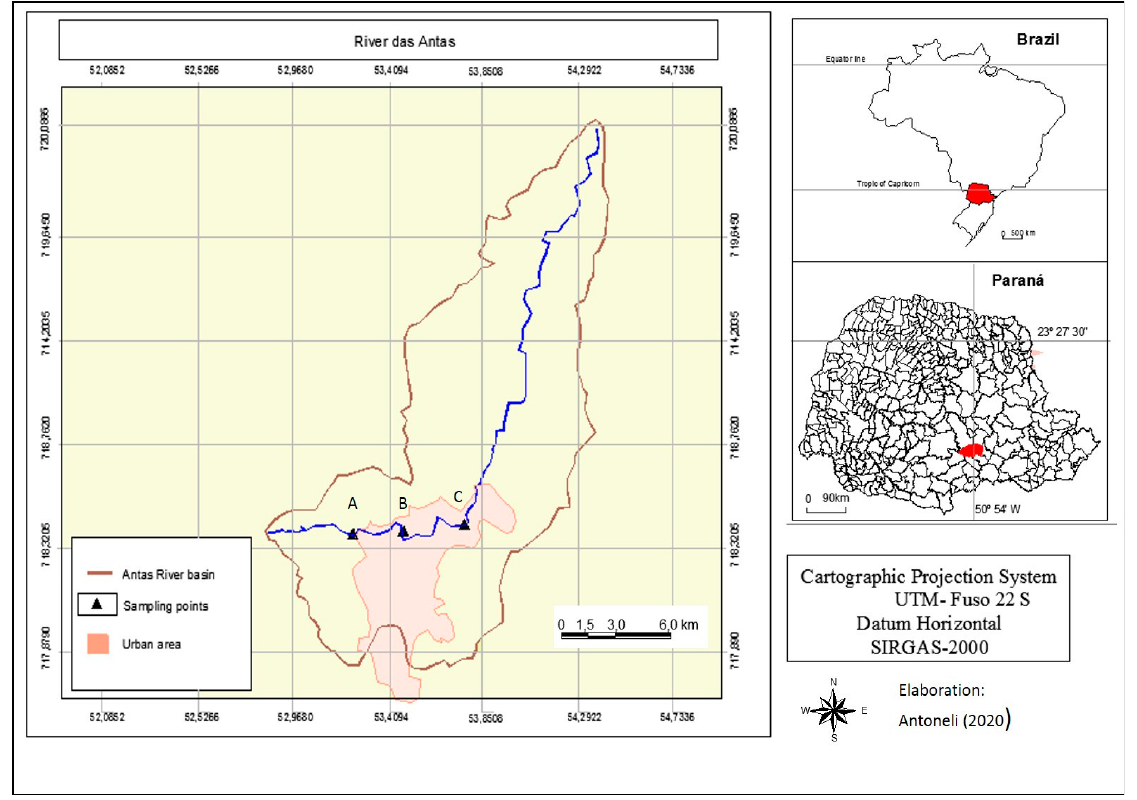
Figure 1. Geographical location of the study area. A: rural area, B: poor community (effects of agriculture), C: rich neighbourhood (combined effects of agriculture and urban sprawl); water flows from point “A” (higher elevations) to point “C” (lower elevations).